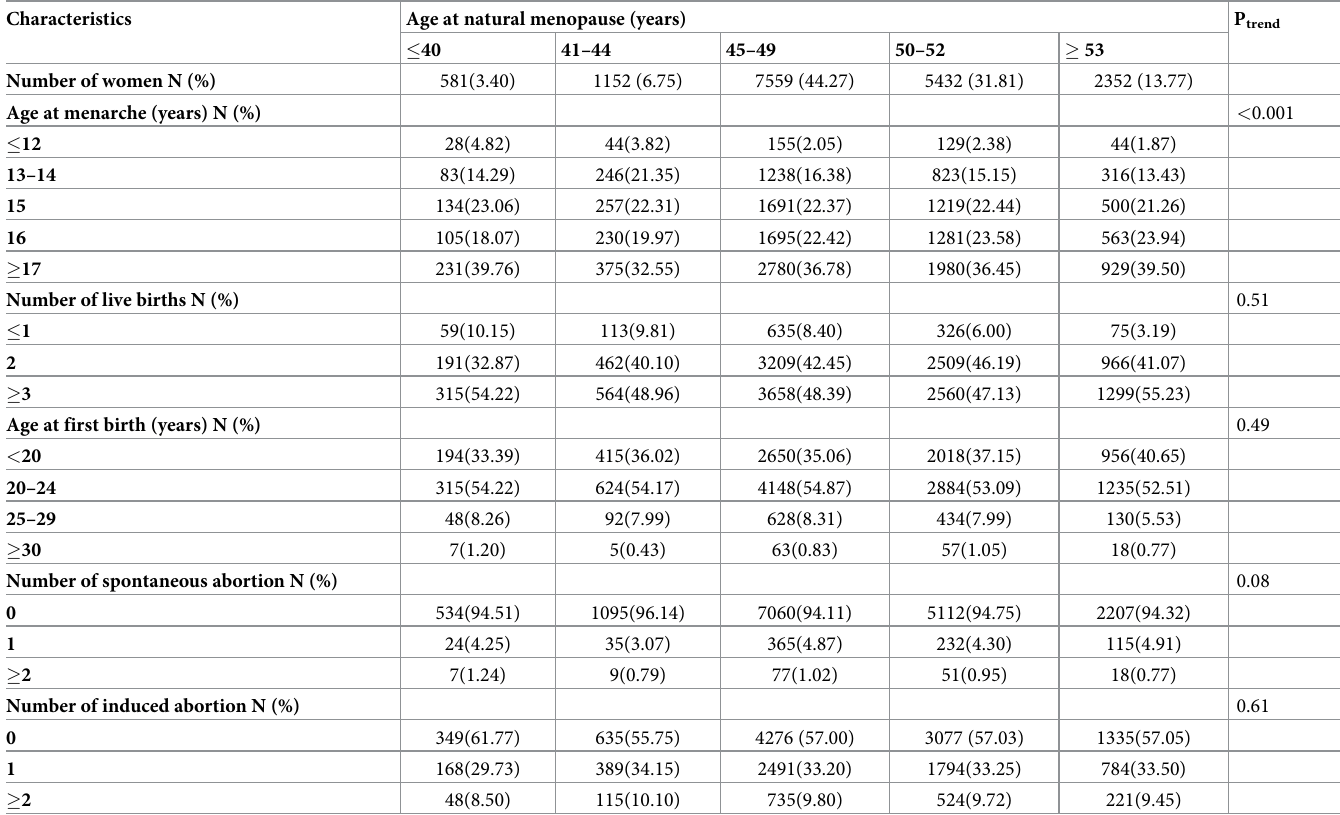
Table 4. Reproductive characteristics of women according to age at natural